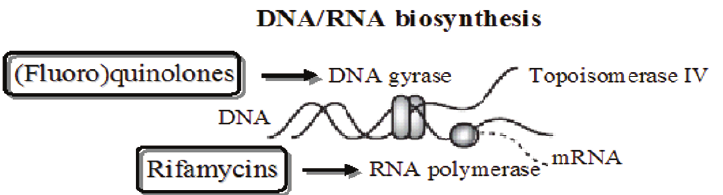
Figure 5. (Fluoro)quinolones and rifamycins interfere with nucleic acid biosynthesis. (Fluoro)quinolones inhibit DNA synthesis by interacting with DNA gyrase and topoisomerase IV resulting in inhibition of normal enzyme activity. Rifamycins act as allosteric inhibitors of the bacterial DNA-dependent RNA polymerase resulting in inhibition of transcription.